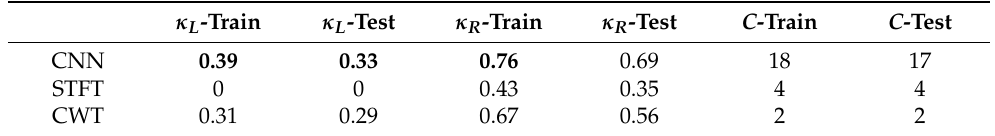
Figure 4. Low-dimensional representations of the sleep–wake dataset. Each dot represents 1 s of data. First row ( A – C ): CNN. Second row ( D – F ): STFT. Third row ( G – I ): CWT. First column ( A , D , G ): all data. Second column ( B , E , H ): training data. Third column ( C , F , I ): test data. Table 2. Quantitative measures for the sleep–wake dataset. Significantly higher values in a column are in bold (chi-square test); κ indicates the kappa value for SVM; L indicates a linear kernel; R indicates a radial basis function kernel; C indicates the number of clusters by k-means. 𝜿 𝑳 -Train Table 3. Quantitative measures for the IED dataset. Significantly higher values in a column are in bold (chi-square test). κ indicates the kappa value for SVM; L indicates a linear kernel; R indicates a radial basis function kernel; C indicates the number of clusters by